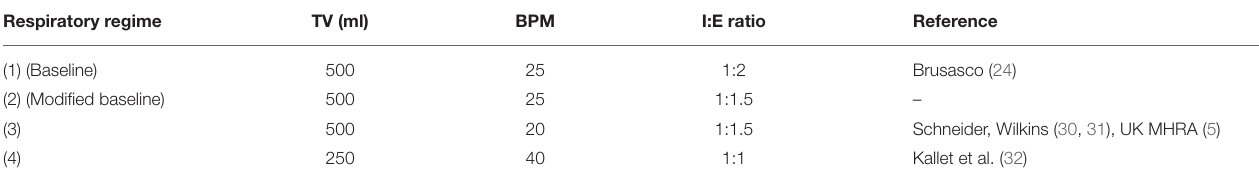
TABLE 1 | Respiratory regimes used to evaluate the LeVe system defined by the simulated lung parameters Tidal Volume (TV), Breaths per Minute (BPM) and Inspiration:Expiration (I:E) ratio (the time taken for each phase of the breathing cycle). Respiratory regime TV (ml) BPM I:E ratio